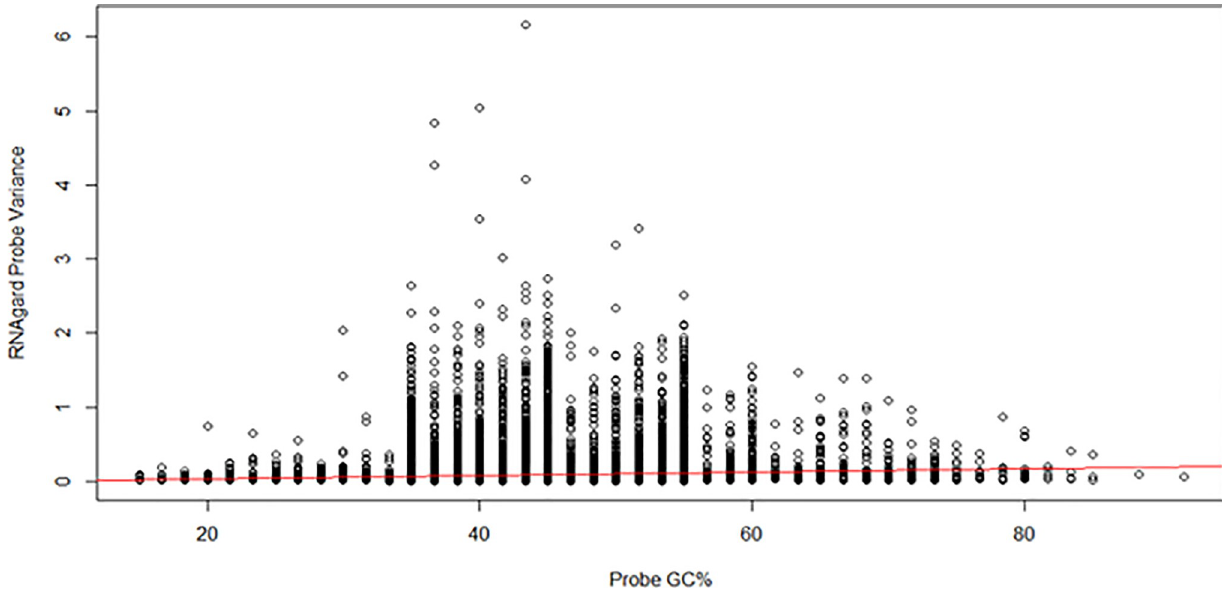
Fig 3. Modest positive trend of increased probe variance and GC content. Scatter plot showing RNAgard 1 probe variance by GC%. Red line shows linear regression fit.